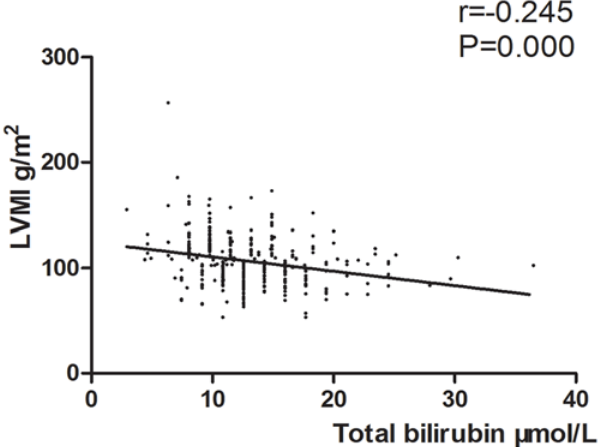
Fig 1. Scatter diagram of total bilirubin level between the LVMI.